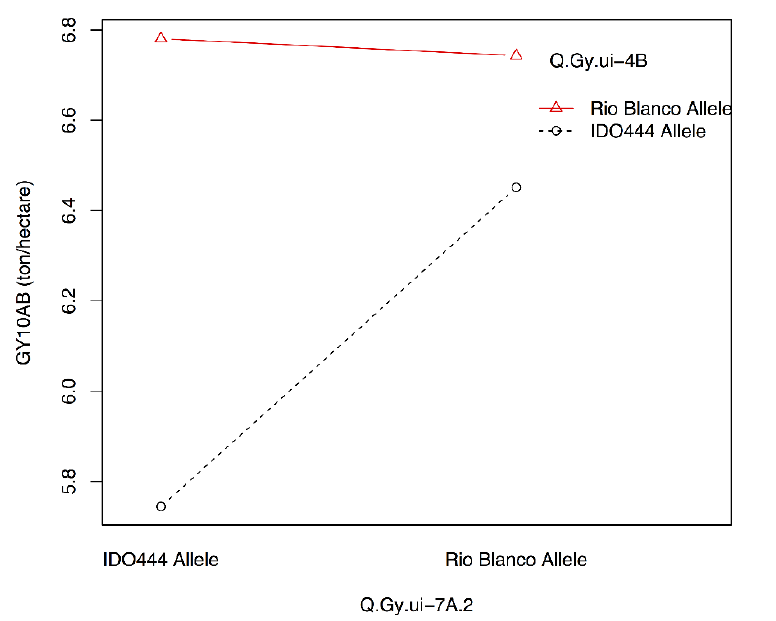
Figure 3. Interaction between two QTL for grain yield in